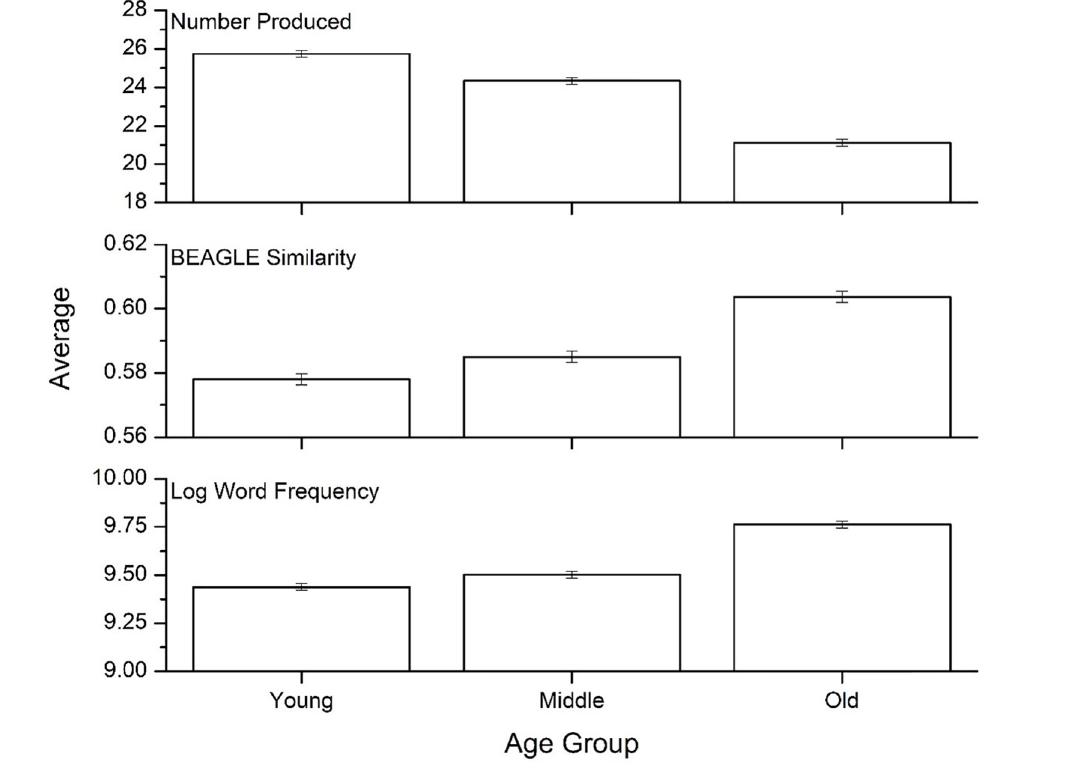
Fig 2. Means for the three psycholinguistic variables across the three age groups. Error bars represent 95% confidence